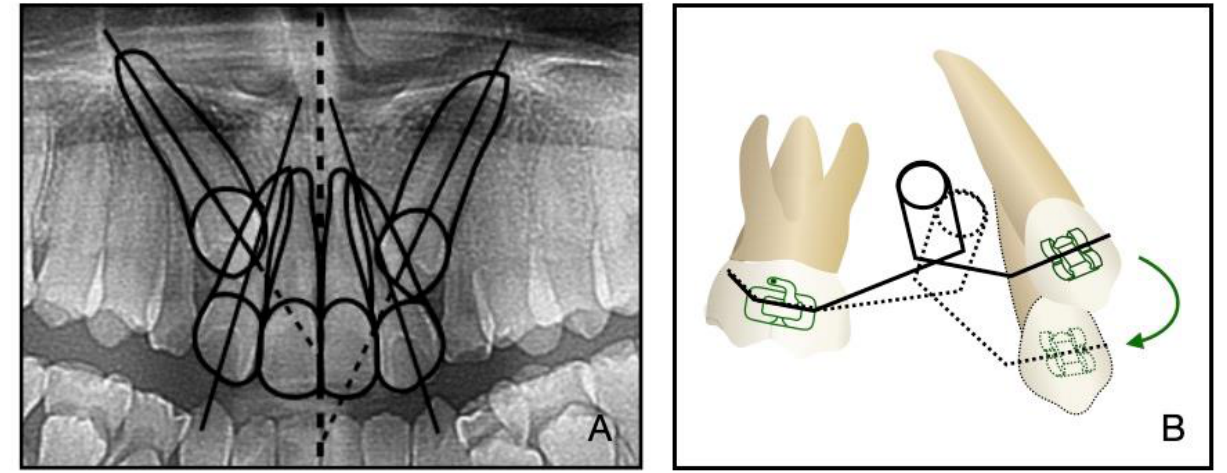
Figure 12. ( A ): The relative position of the canine crown and lateral incisor in a panoramic radiograph. ( B ): Biomechanism of canine traction through segmental arch. The green arrow illustrates the path of canine movement.